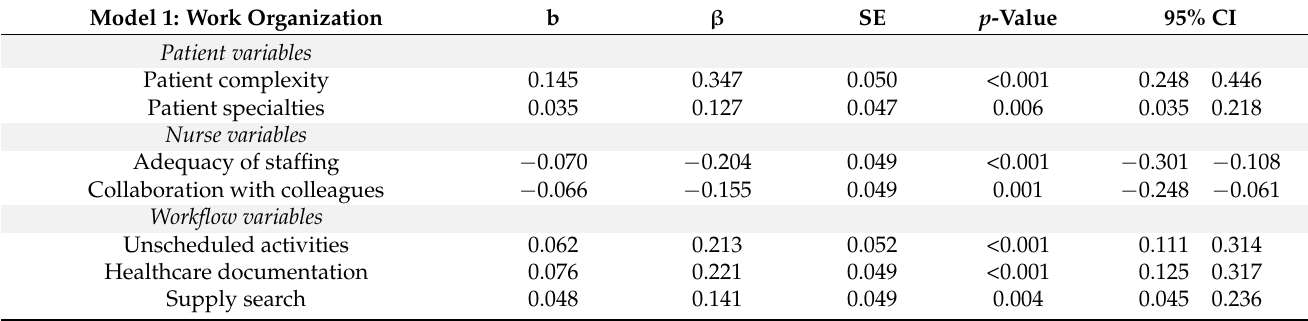
Table 2. Multivariable regression effects of the patient, nurse, and workflow variables on nurses’ work organization and effects of nurses’ work organization on perceived physical, mental, and emotional workloads (N =